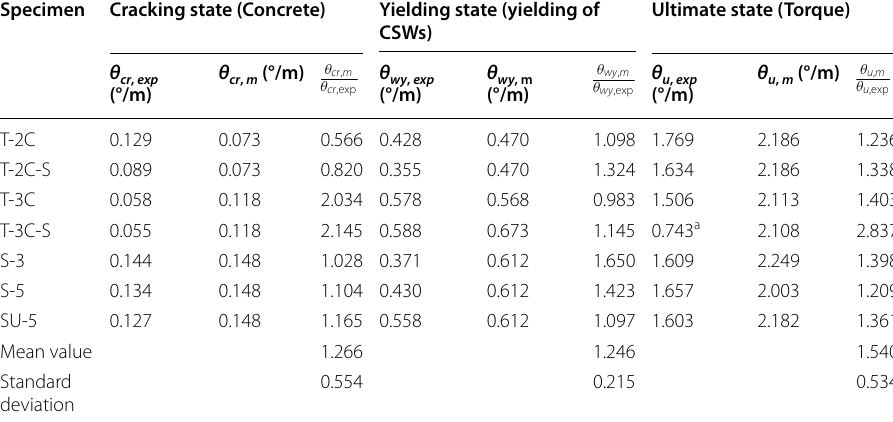
Table 3 Prediction accuracy of the USMMT on twists at the characteristic points Specimen Cracking state (Concrete)